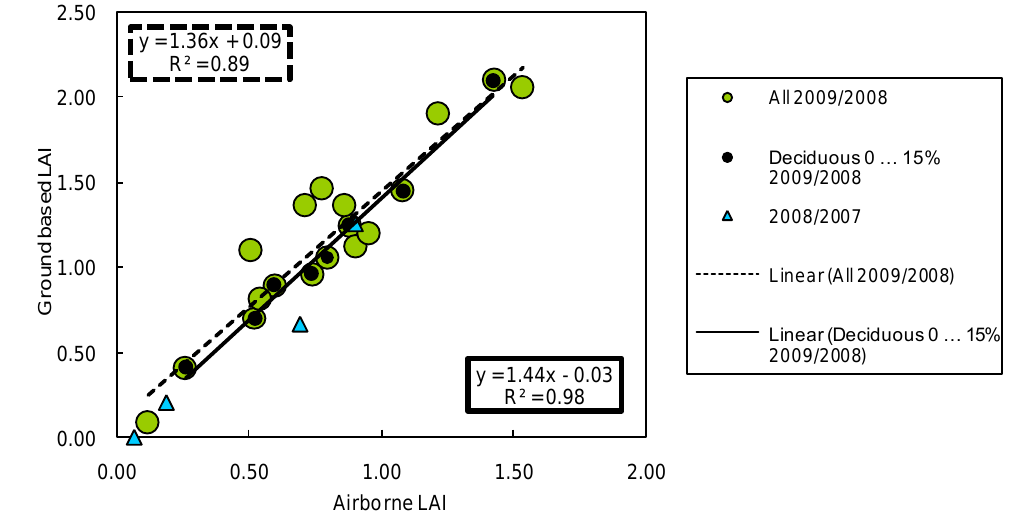
Figure 8. Relationship of the ground based and airborne LAI values. The airborne values were measured in March 13, 2009 and corresponding ground measurements were carried out during August 26–September 5, 2008 The points for airborne measurements 2008 and ground measurements 2007, for which the airborne location is closer than 30 m to that of the ground measurements and which don’t have deciduous LAI contribution, are shown as